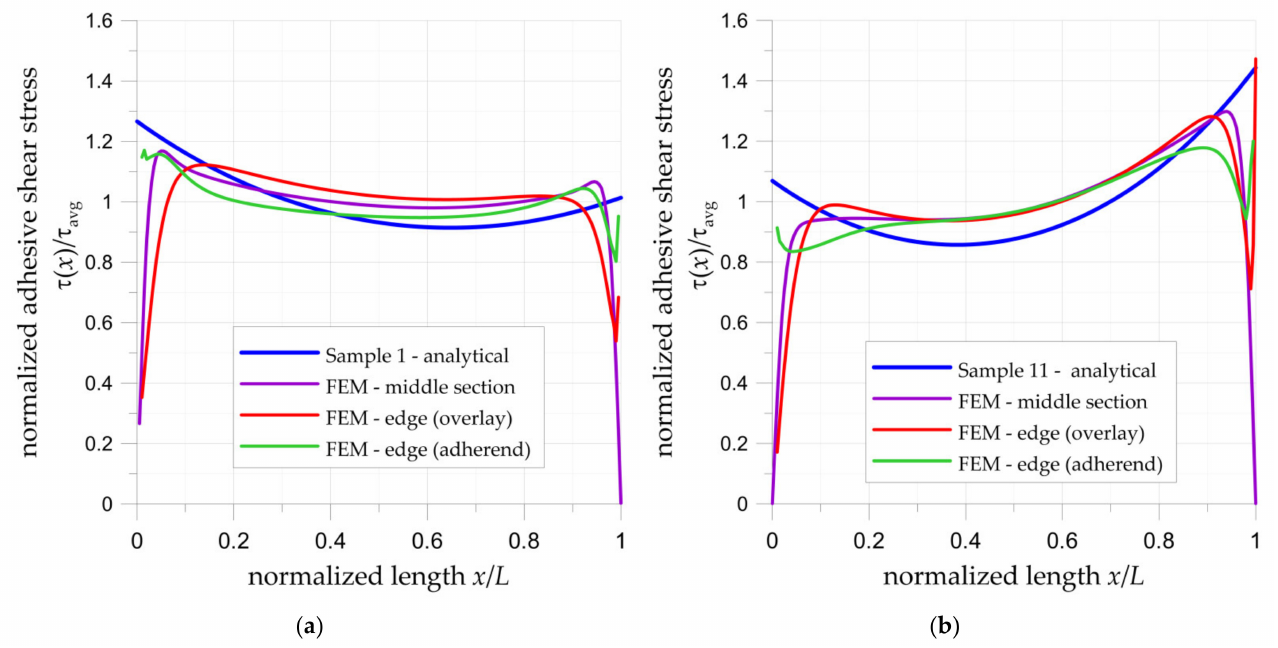
Figure 14. Distribution of normalized adhesive shear stresses in adhesive in double-lap joints calculated by analytical and numerical approaches: ( a ) sample no. 1 with steel overlays; ( b ) sample no. 11 with composite